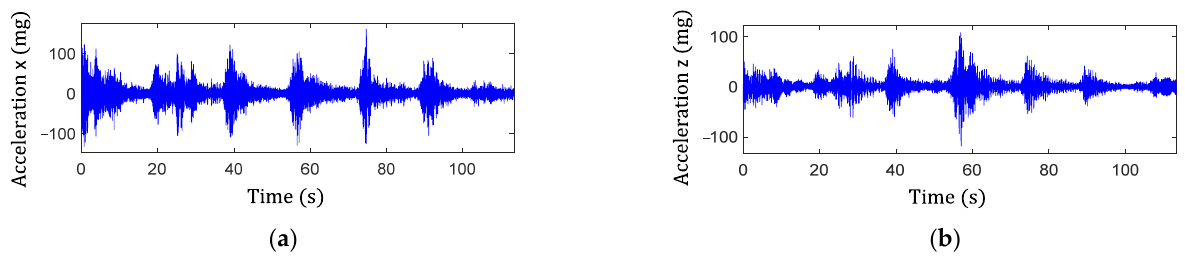
Figure 16. Acceleration measurements containing multiple impulse traffic events: ( a ) lateral direction and ( b ) vertical direction.